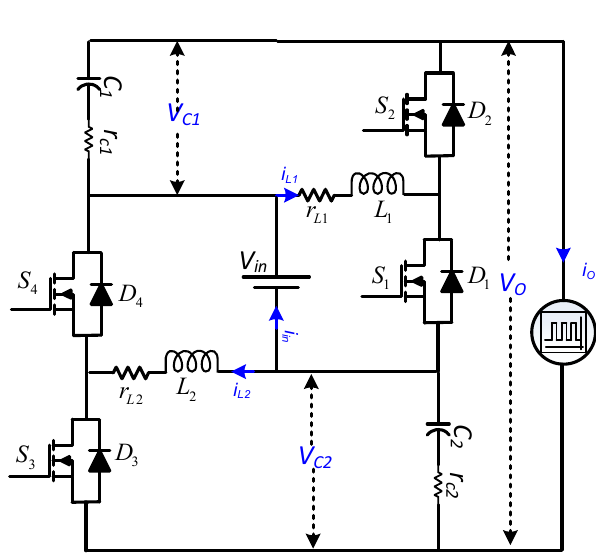
Figure 2. Interleaved differential capacitor clamped boost converter.